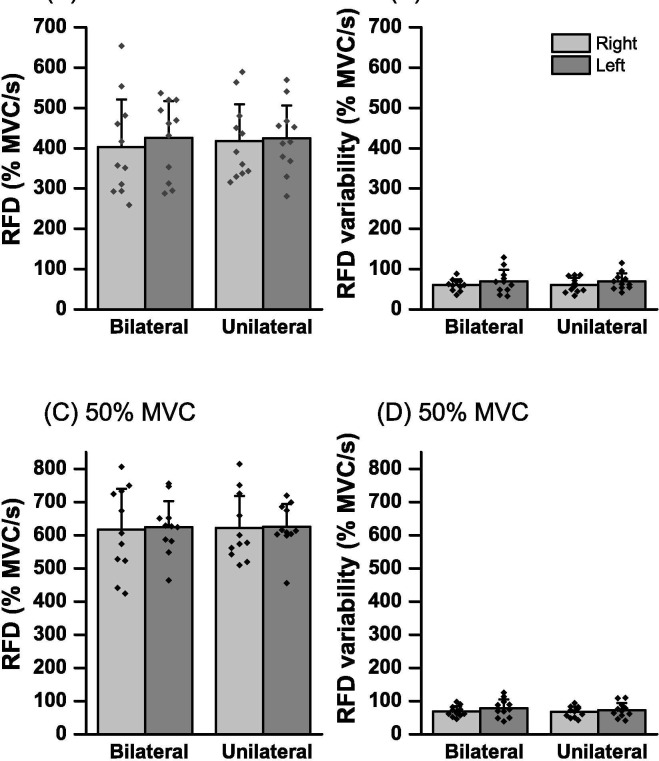
Mean rate of force development (RFD) in right- (gray bar) and left-hand (dark gray bar) for bilateral and unilateral contractions.Dot presents the value for each individual. (A) mean peak RFD of 30% of maximal voluntary contraction (MVC) target, (B) RFD variability of 30% of MVC target, (C) mean peak RFD of 50% of MVC target and (D) RFD variability of 50% of MVC target.